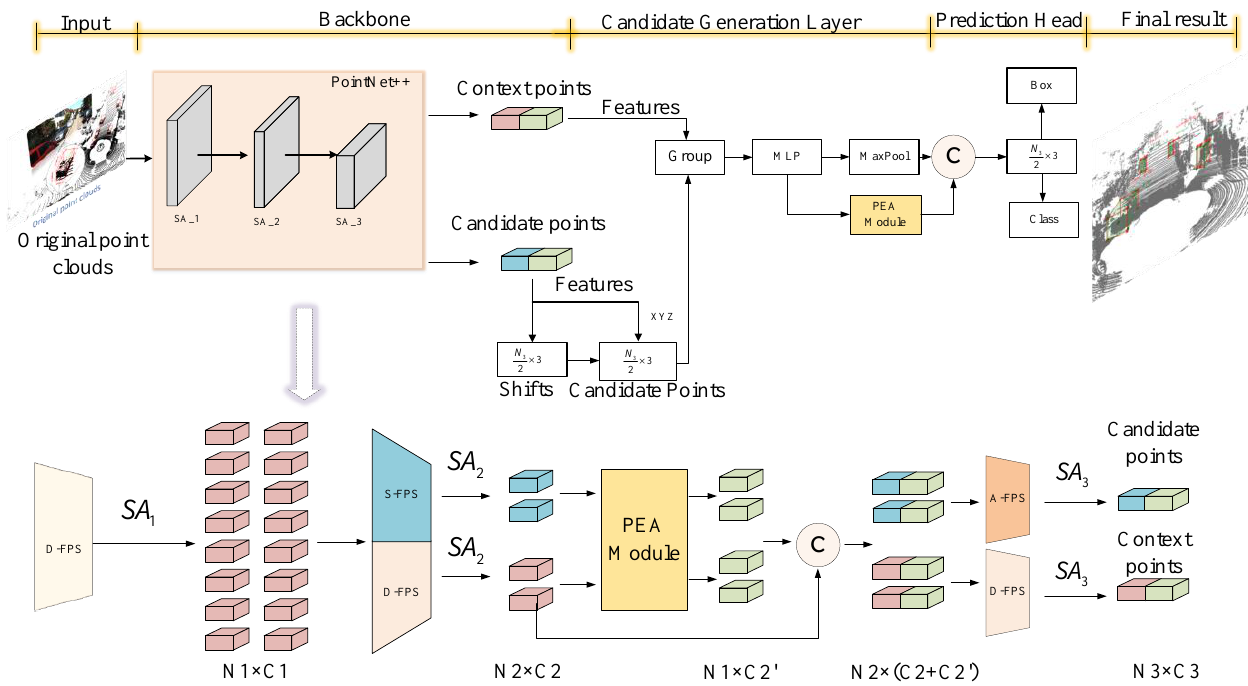
Figure 2. Illustration of the entire AGS-SSD framework. First, the network performs feature extraction using three SA layers. Second, the PEA module is inserted between SA 2 and SA 3 to extract the contextual information on the features extracted by SA 2 . The PEA module is also added to the CG layer to shift the sampled points to the corresponding instance centres. Third, the A-FPS module samples the key point set K based on the point coordinates X and attention scores P. Finally, the prediction head gives the class score and regression bounding box prediction. In the lower part of the image, the blocks output by SA represent the ratio of the cloud of the downsampling points, i.e., 16:4:2:1.